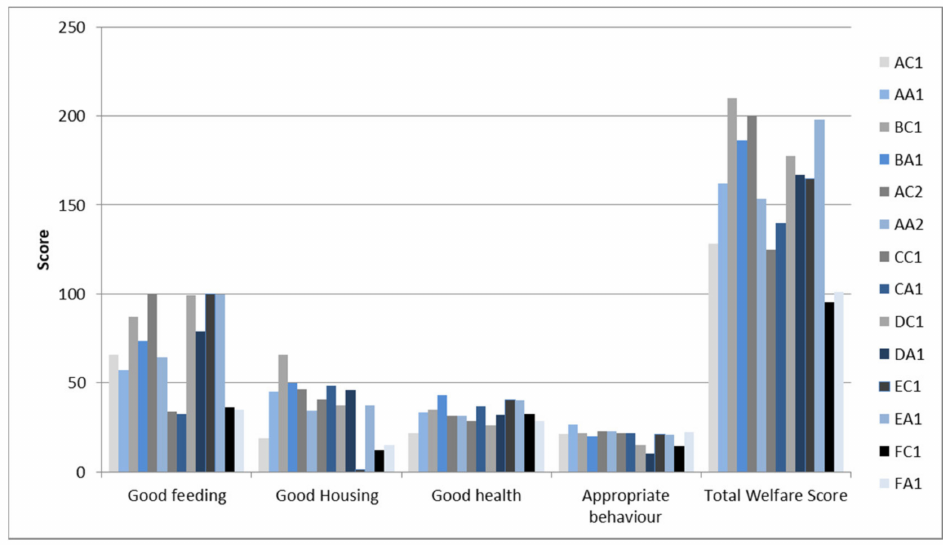
Figure 1. Scores assigned to each batch using the Welfare Quality ® protocol. The results of the four principles (good feeding, good housing, good health and appropriate behavior) and the total welfare score of each of the 14 batches are displayed. Pairs of batches evaluated on the same day (conventional vs. antibiotic free) are shown near each other. The conventional batches are in the grey color scale, and the antibiotic-free batches are in the blue color